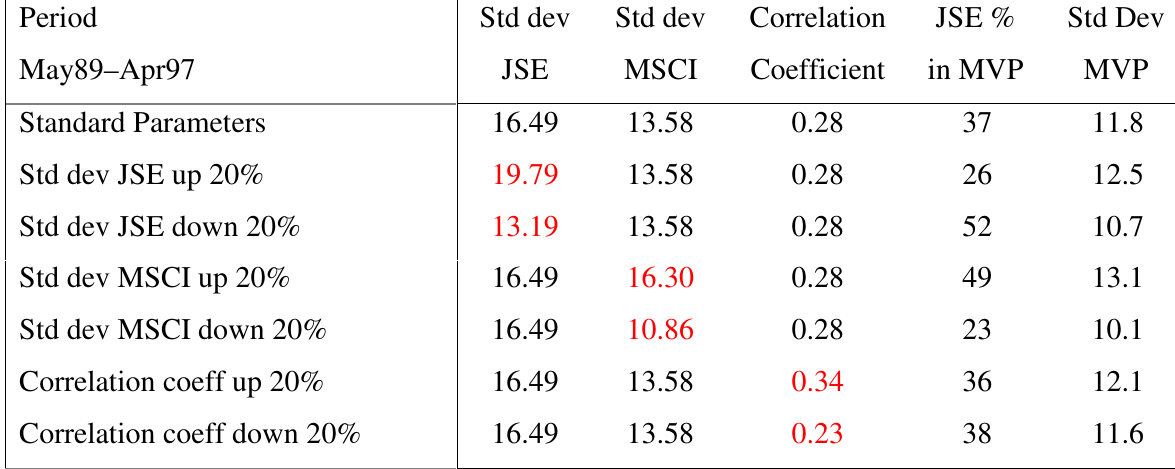
Table 4. Model sensitivity to single parameter